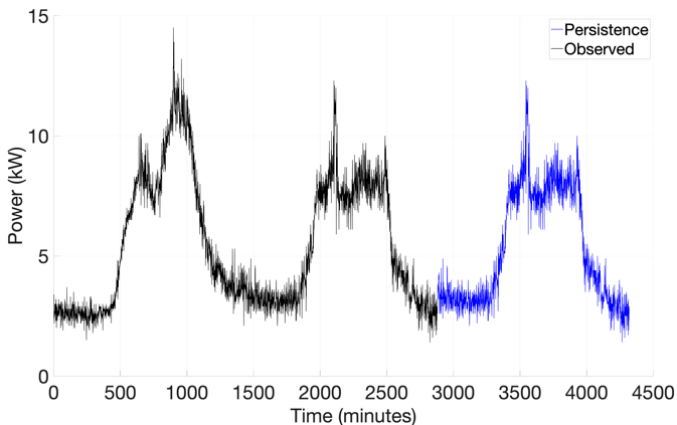
Figure 10. Persistence applied in home 1 forecasting.